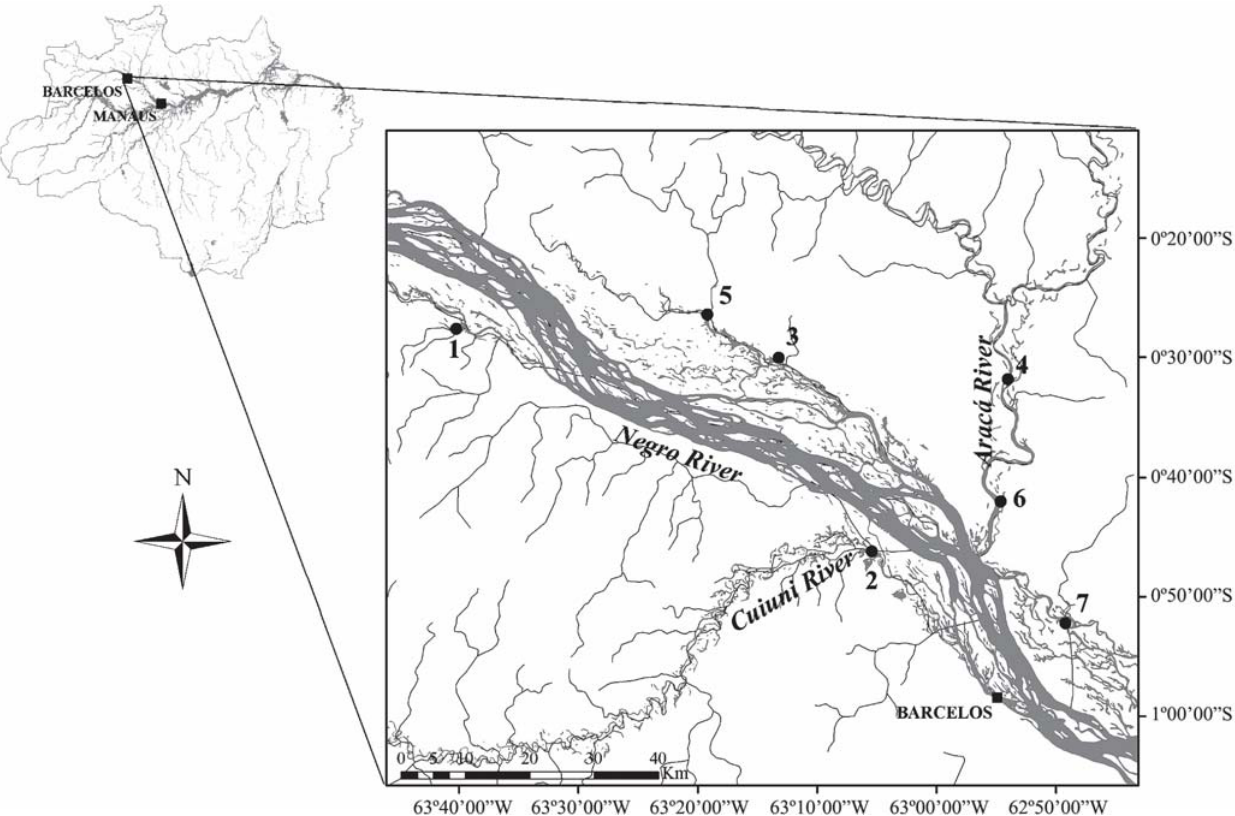
Fig. 1. Sampling sites of Potamotrygon motoro , P . orbignyi , Potamotrygon sp. “cururu” and Paratrygon aiereba , in the middle Negro River, Barcelos, Amazonas State, Brazil. 1) Arirahá River; 2) Cuiuni River; 3) Daraquá stream; 4) Demeni River; 5) Itu River; 6) Maqui Lake; 7) Zamula